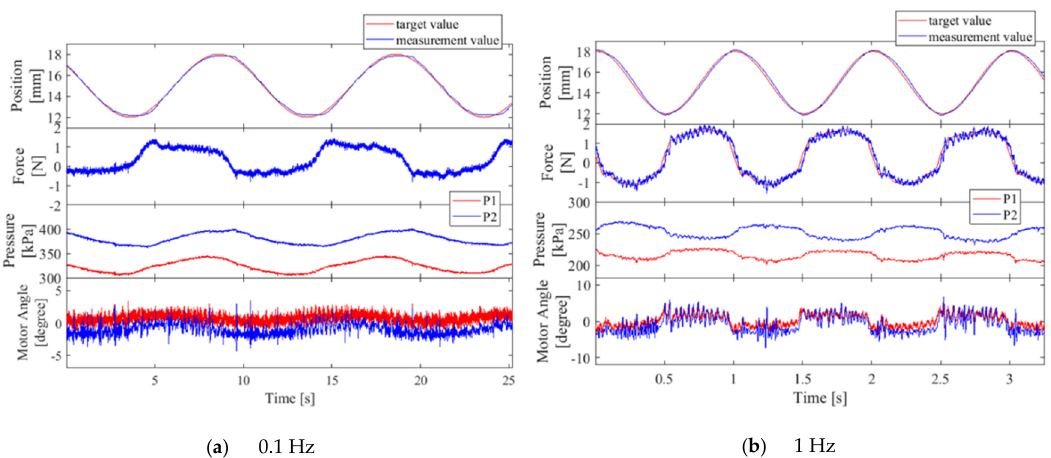
Figure 15. Experimental results of piston control of a pneumatic cylinder with the developed pinch-type servo valve.